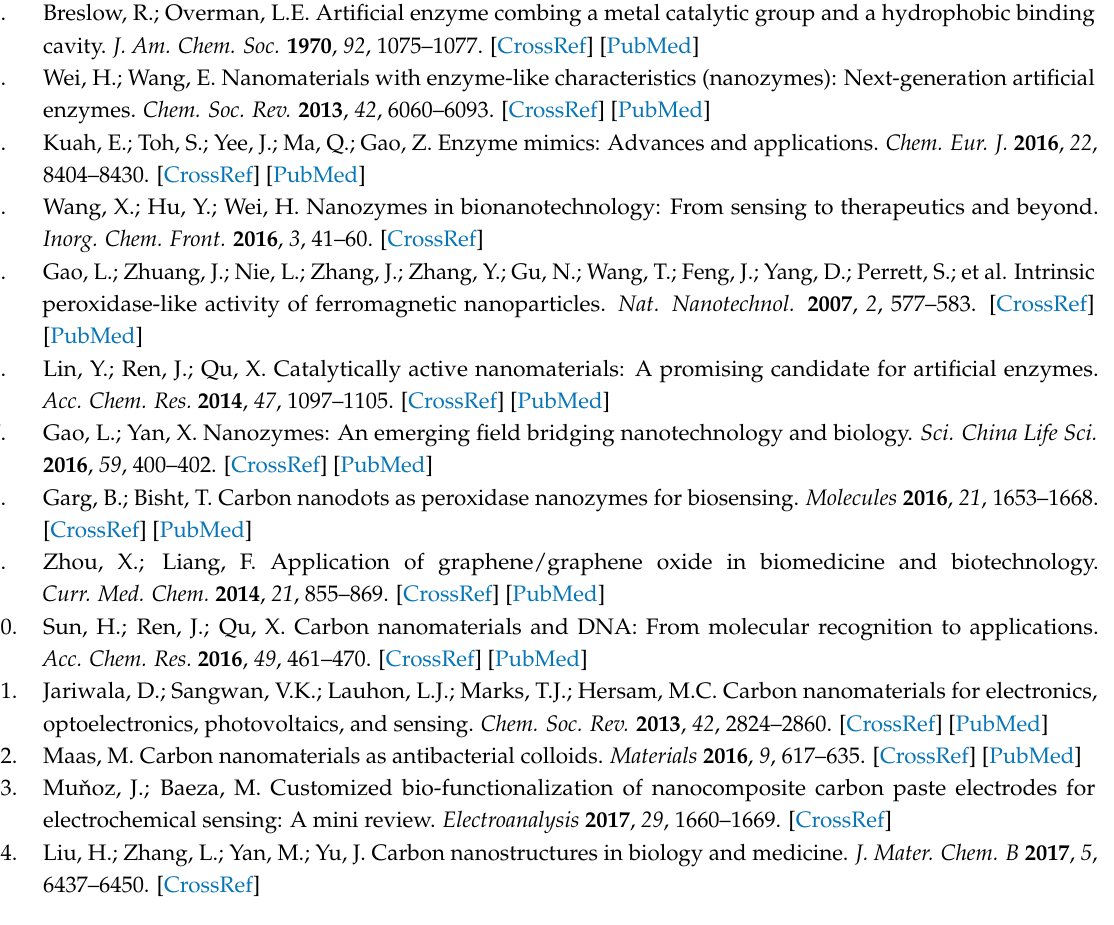
Figure S1: FT-IR Spectrometer of as-synthesized carbon nanomaterials in this work; Figure S2: Raman spectra of as-synthesized carbon nanomaterials in this work; Figure S3: Zeta potential of as-synthesized carbon nanomaterials in this work; Figure S4: Effects of pH value, temperature and H 2 O 2 concentrations on the peroxidase catalytic activities of different carbon nanomaterials; Figure S5: The time-dependent absorbance at 652 nm in the presence of 40 µ g · mL − 1 different carbon nanomaterials; Figure S6: The kinetic behaviors for as-prepared carbon